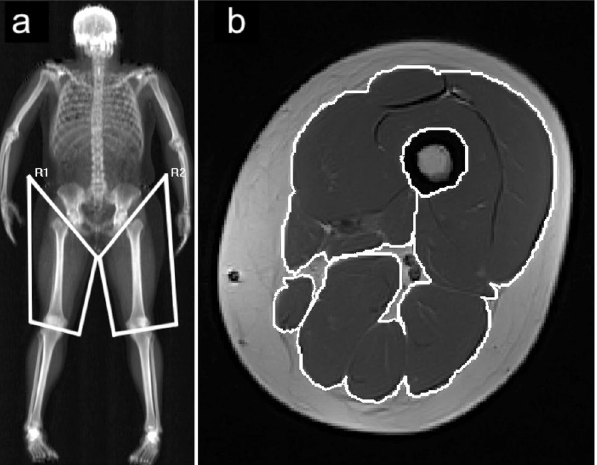
Figure 4. DXA and MRI regions used for analysis. ( a ) Diagram showing regions of interest in DXA scans. ( b ) Magnetic resonance image of the mid-thigh, muscles included for analysis traced in